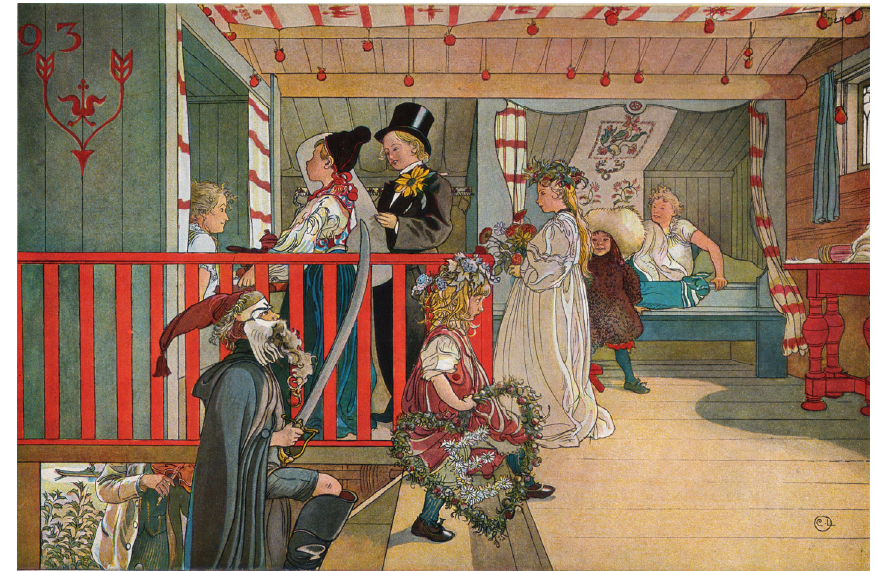
Figure 7. Carl Larsson (1853–1919): Namnsdag på härbret (“Nameday in the Storage House”),